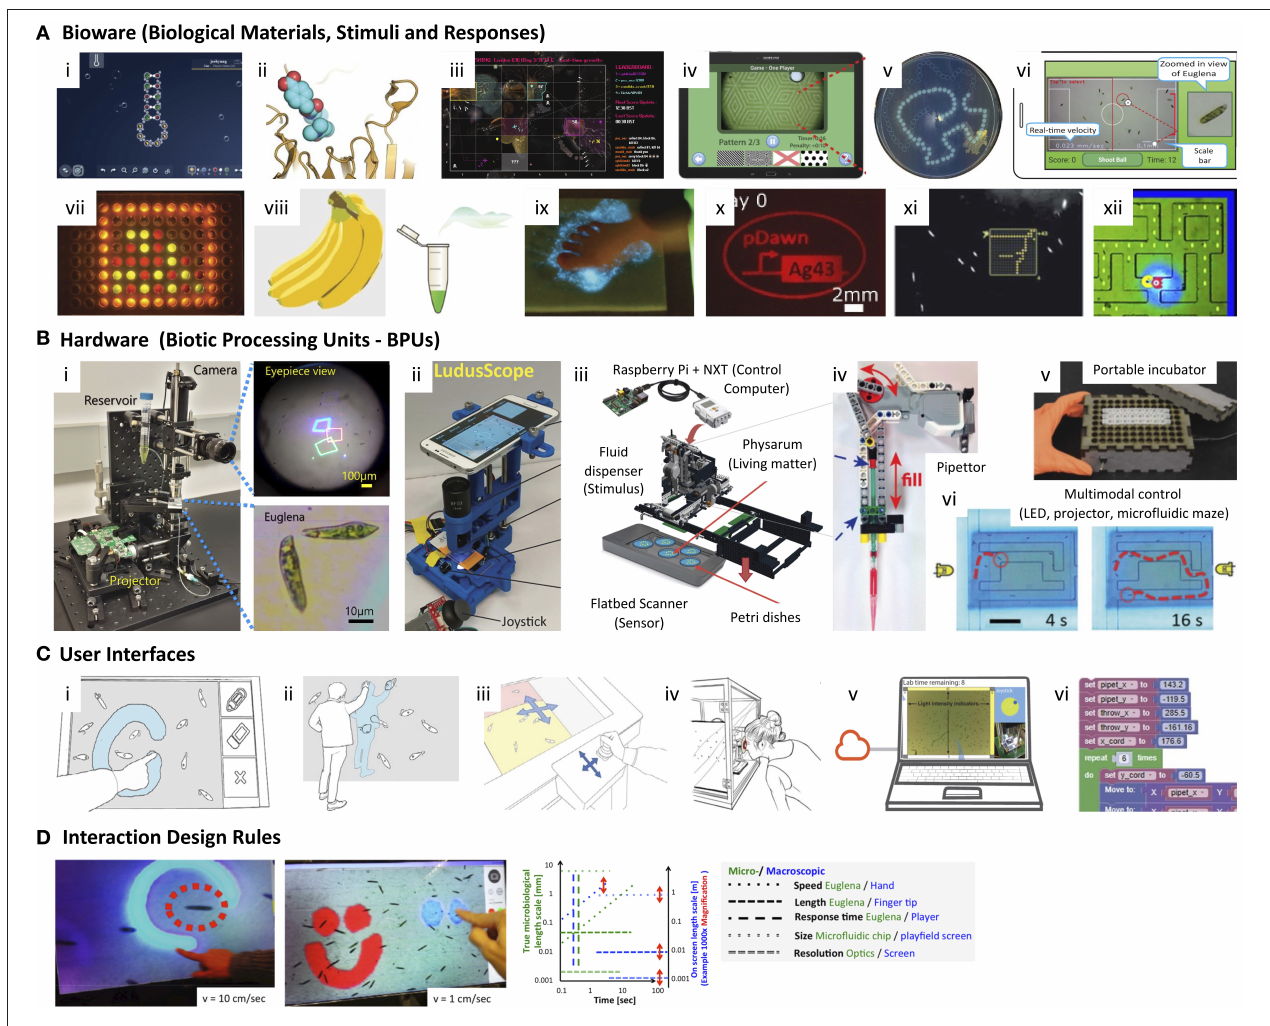
FIGURE 2 | Key aspects of micro-HBI and illustrative examples: (A) Bioware (Biological materials including stimuli and responses): (i) RNA folding (EteRNA) (Lee et al., 2014 ); (ii) Protein folding (Foldit) (Eiben et al., 2012); (iii) Fungi growth (Mould Rush) (Kim et al., 2019); (iv) Euglena (swarm) photo-bioconvection (Biographer) ( Gerber et al., 2016a); (v) Physarum chemotaxis (Turn-based cloud lab) (Hossain et al., 2015); (vi) Euglena (multicell) phototaxis (LudusScope) (Kim et al., 2016); (vii) In vitro fluorescent protein expression (BioBits) (Stark et al., 2018); (viii) Chemical detection through smell and fluorescence (BioBits) (Huang et al., 2018); (ix) Mechanical fluorescent activation with dinoflagellates (Hopscotch game) ( Ofer et al., 2021); (x) Bacterial deposition via light (Biofilm Lithography) (Jin and Riedel-Kruse, 2018); (xi) Paramecium galvanotaxis (biotic games) (Riedel-Kruse et al., 2011); (xii) Euglena (single cell) phototaxis (microfluidic Pac-Man maze) (Lam et al., 2020). (B) Hardware (“biotic processing units”-BPUs): (i) Light-projector and optics microscopy (Lee et al., 2015a); (ii) LEDs and low-cost smartphone microscope (Kim et al., 2016); (iii) LEGO pipetting robot and flatbed scanner (Hossain et al., 2015); (iv) LEGO pipettor (Gerber et al., 2017); (v) Portable incubator/plate reader (Stark et al., 2018); (vi) Multimodal swarm programming (LED, projector, microfluidic maze) (Lam et al., 2017). (C) User Interfaces : (i) Touchscreen (Lam et al., 2019); (ii) Full-body interaction (Lam et al., 2019); (iii) Microscope operation (Lam et al., 2019); (iv) Passive observation (Lam et al., 2019); (v) Web-based user interface for cloud lab (Hossain et al., 2016); (vi) Direct programming interface for liquid handler control (Gome et al., 2019). (D) Interaction Design Rules : Specific design rules need to be followed to match the time and length scales of the macroscopic human actions with the microscopic biological responses (Gerber et al.,